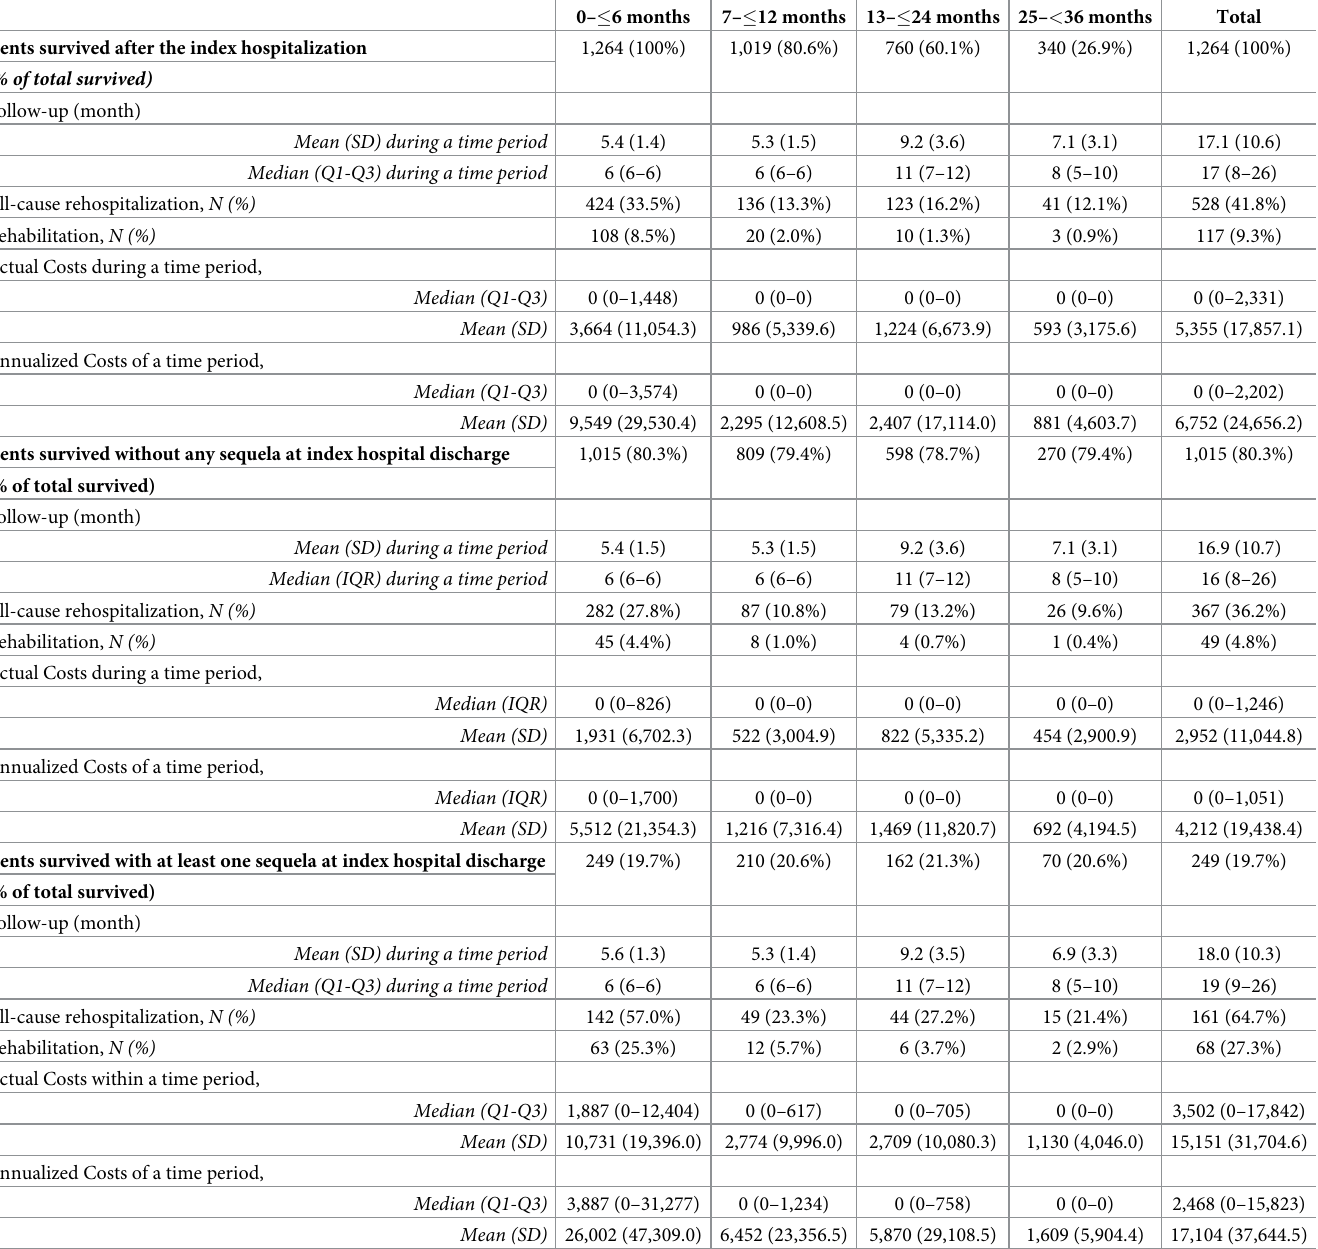
Table 3. Healthcare utilization over the follow-up